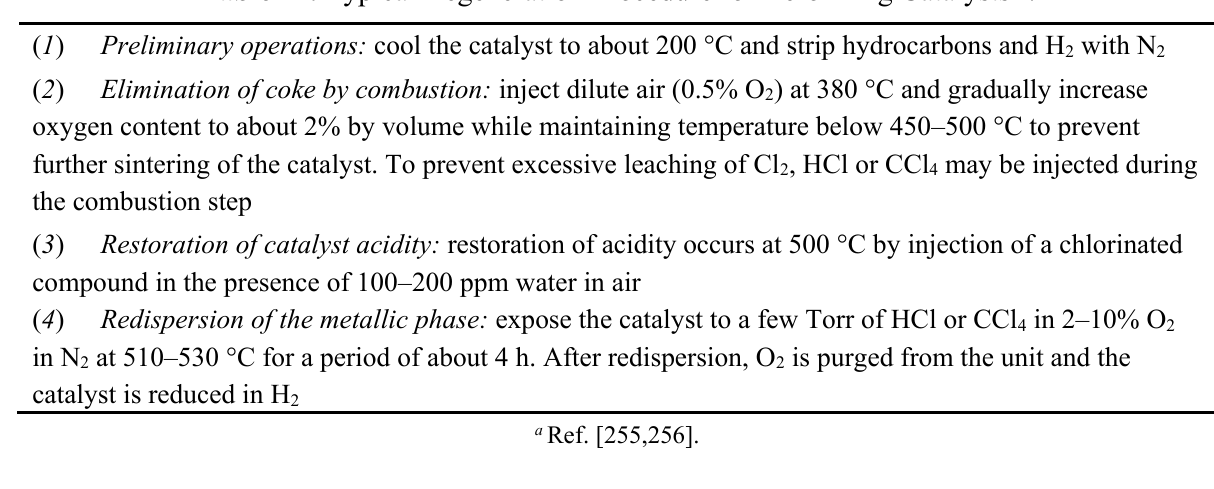
Table 22. Typical Regeneration Procedure for Reforming Catalysts a